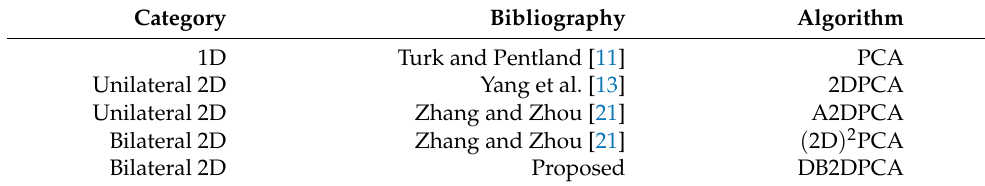
Table 9. Five algorithms compared in the